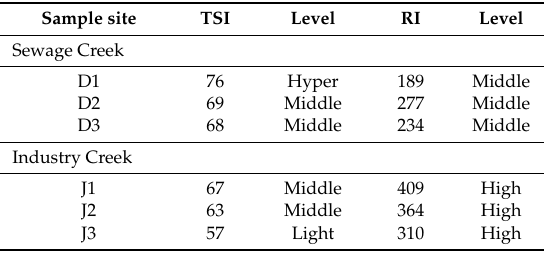
Table 5. Tropic state index and ecological risk of the two